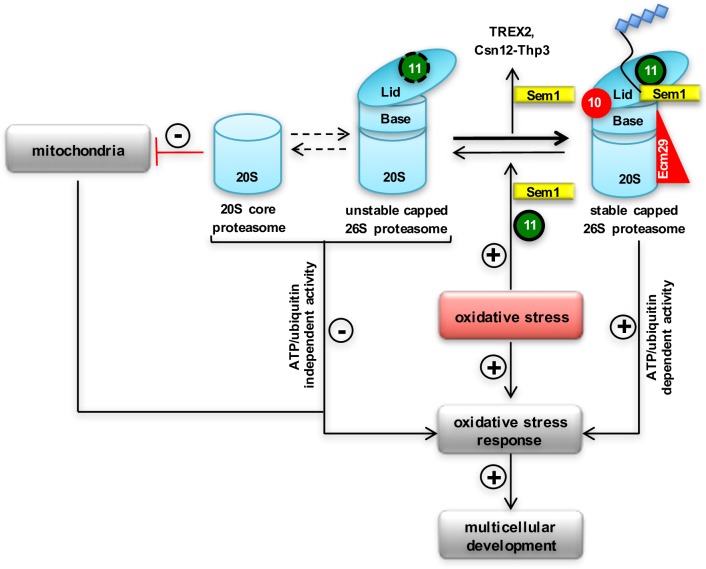
Molecular Sem1 function and A. nidulans multicellular development.Sem1 links cellular redox state, mitochondria integrity, efficient assembly of several complexes including the 26S proteasome to multicellular differentiation. Oxidative stress induces the oxidative stress response. Multicellular development requires an internal reactive oxygen species (ROS) as a signal as well as protection against oxidative stress. Oxidative stress induced transcription of genes for proteasome subunits sem1 and rpn11 (indicated with +). Capped proteasomes, which can be formed in the presence or absence of Sem1, differ in composition and quantity. Sufficient amounts of Sem1 and Rpn11 are required during oxidative stress to provide correctly assembled 26S proteasomes including the ubiquitin receptor Rpn10, the tethering factor Ecm29 and stabilized full-length deubiquitinating enzyme Rpn11. Consequently, these stable capped 26S proteasomes are fully functional and can selectively catalyse ubiquitinated proteins (indicated as diamonds) in an ATP/ubiquitin-dependent manner. Decreased amounts of Sem1 result in damaged mitochondria, unstable capped 26S proteasomes and increased levels of activated oxidation-driven 20S core proteasomes, which can efficiently hydrolyse proteins in an ATP/ubiquitin-independent manner.